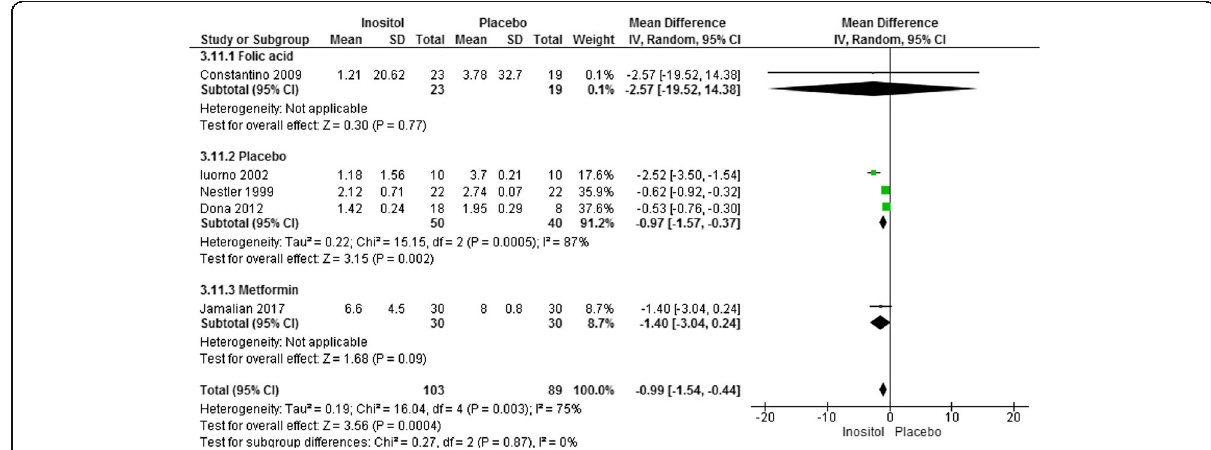
Fig. 3 Meta-analysis inositol versus placebo for total testosterone in women with